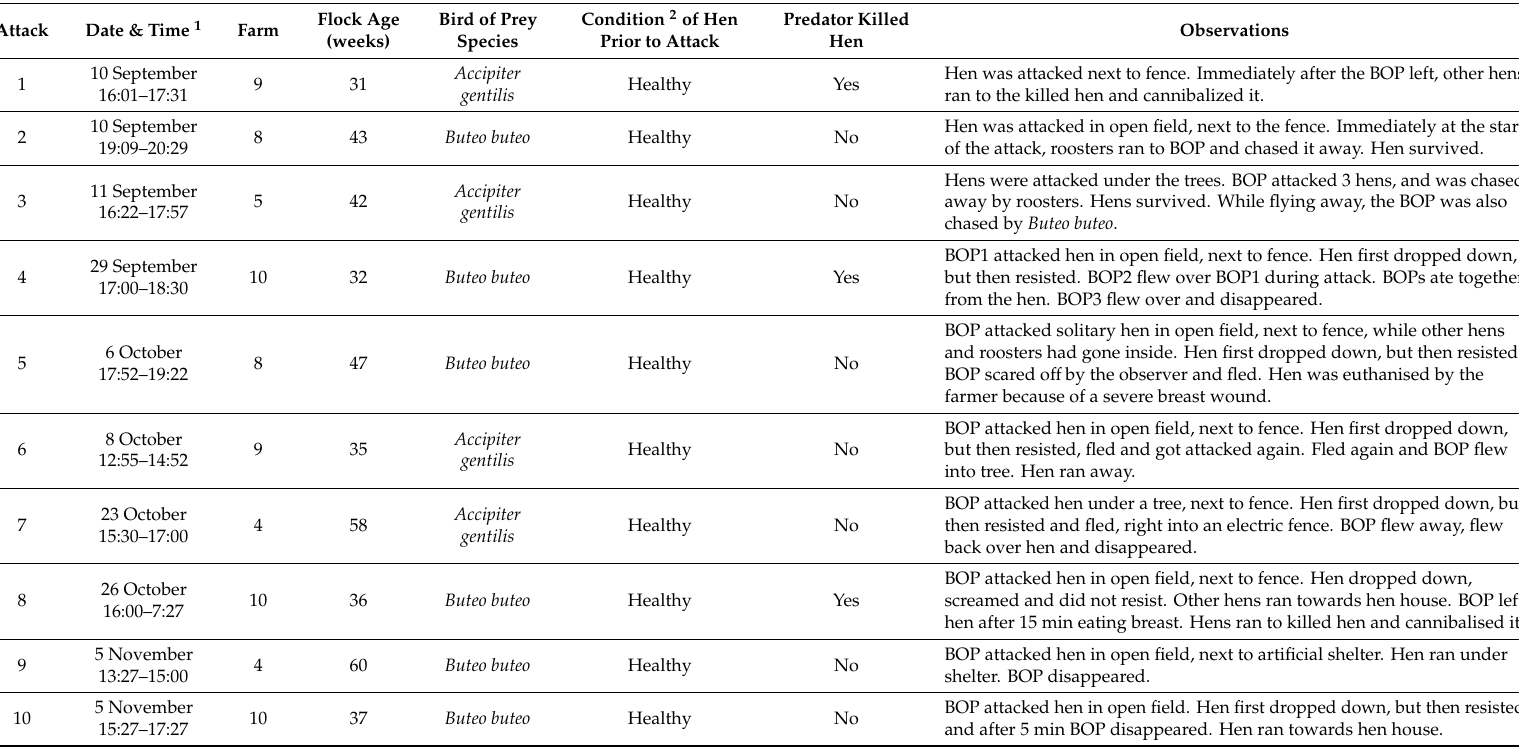
Table 5. Attacks on hens by birds of prey (BOP) seen during field observations, numbered in chronological order.